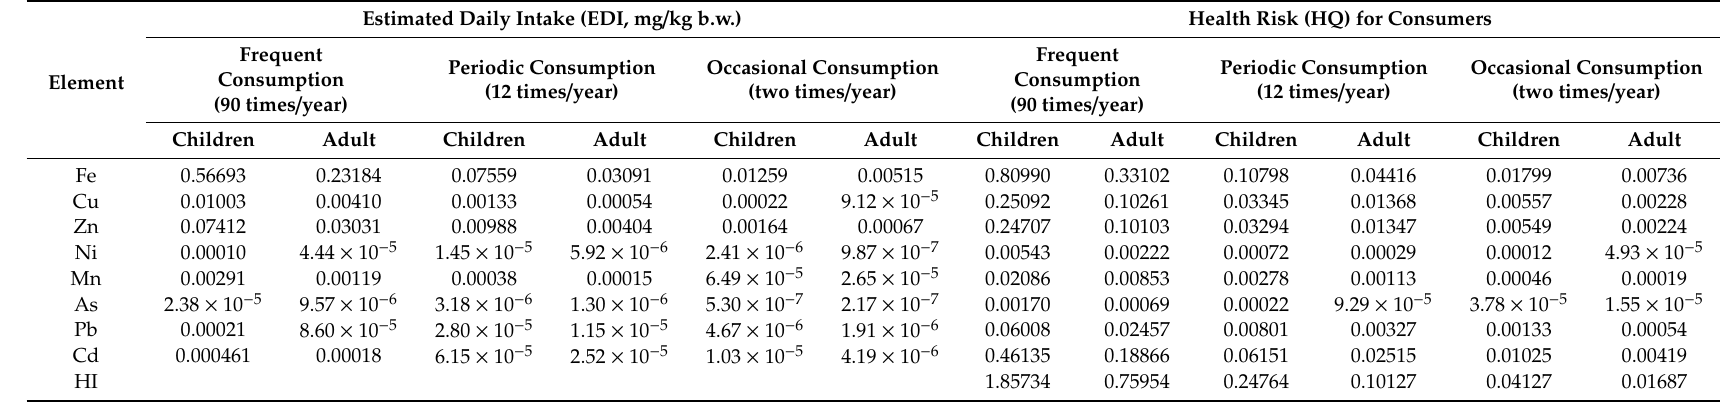
Table 7. Association of the estimated daily intake of elements, health risk (HQ), and hazard index (HI) with consumption of liver of the wild boar from group III. Estimated Daily Intake (EDI, mg / kg Element